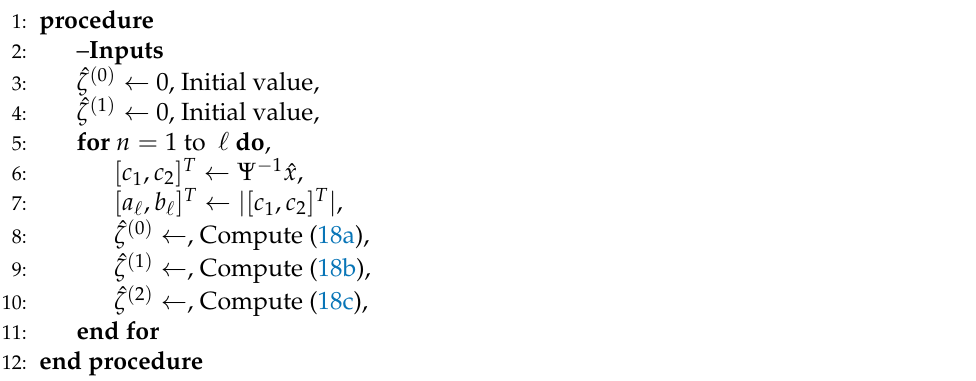
Algorithm 2 Pseudocode to coefficient estimates and signal